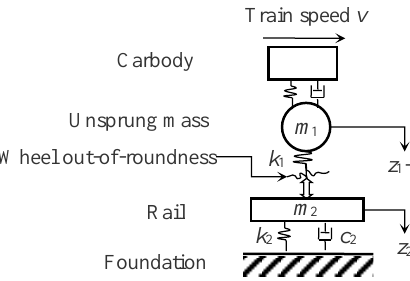
Figure 1. Parameter-lumped simple wheel-track model after introducing wheel out-of-roundness.